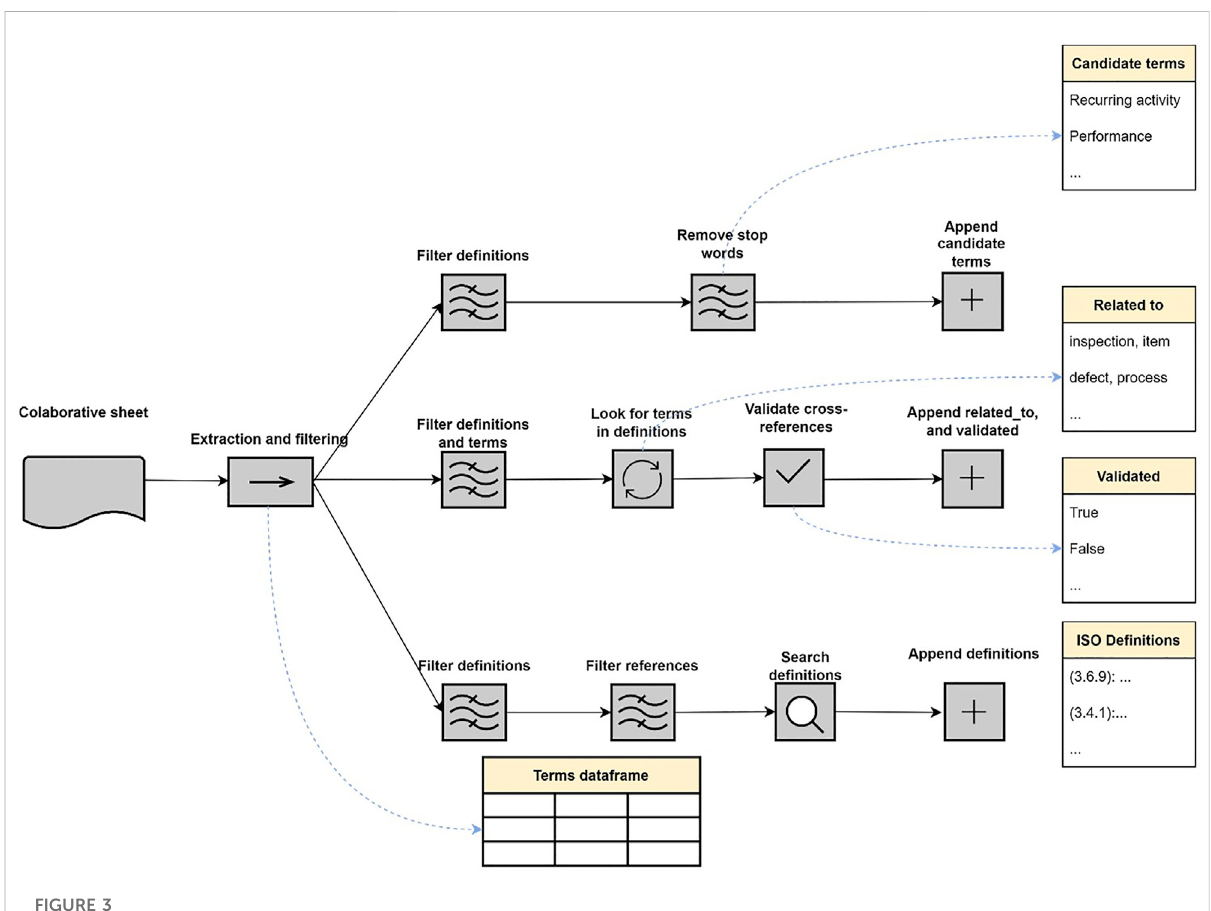
FIGURE 3 Data-processing pipelines of the used